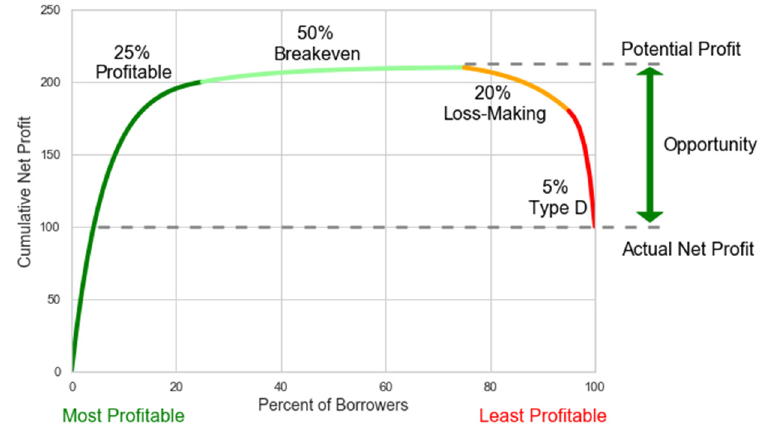
Figure 1. Typical view of whale curve for PDL lending.